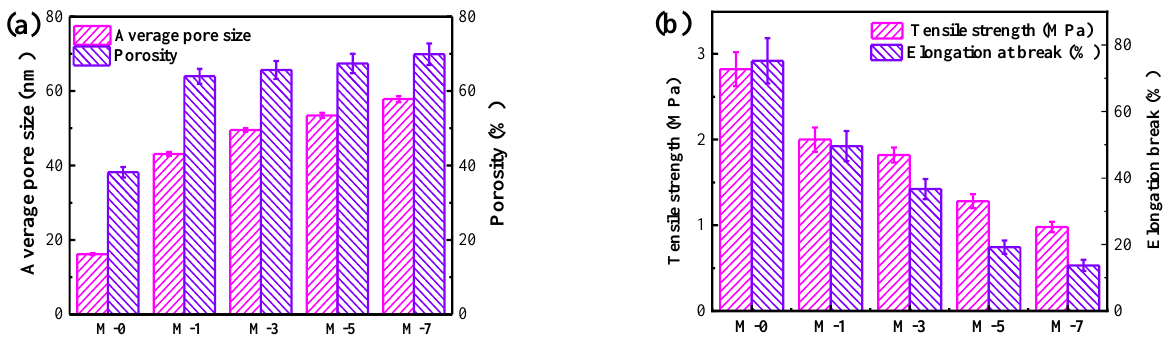
Figure 4. Porosity/average pore size ( a ) and mechanical strength ( b ) of membranes.